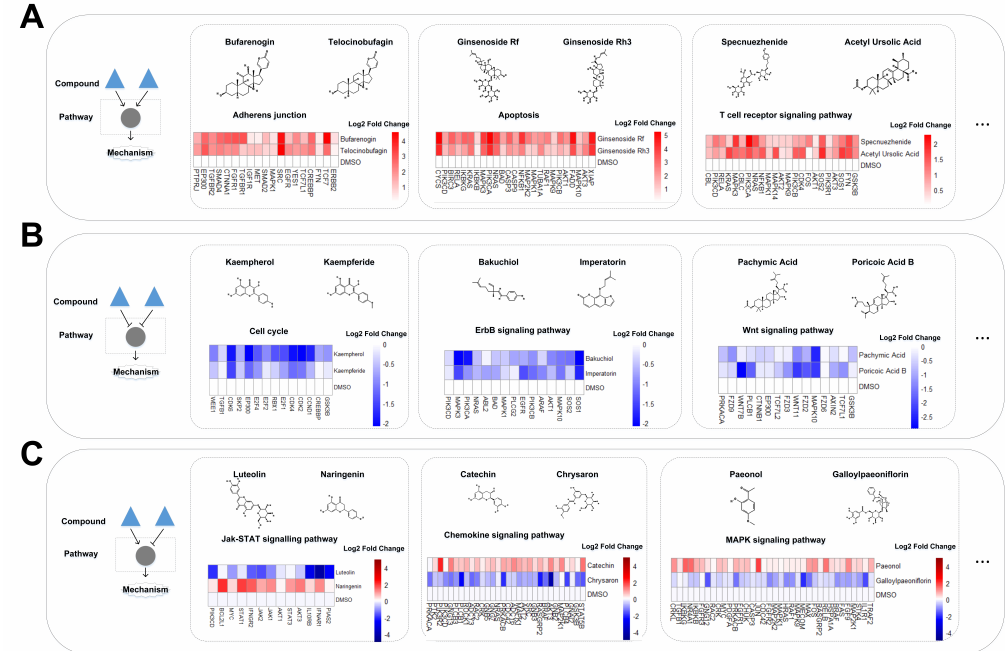
Figure 4. The HTS 2 assay results indicated that within the same pathway, compounds from the same herb may influence gene expression in the same cancer hallmarks (immune-excluded) or immune-related KEGG pathway in the same or opposite directions, as shown in the three boxes. ( A ) Compounds from the same herb may simultaneously upregulate the gene expression in the same pathway. ( B ) Compounds in the same herb may simultaneously downregulate the gene expression in the same pathway. ( C ) Compounds from the same herb may regulate the gene expression in the same pathway in opposite